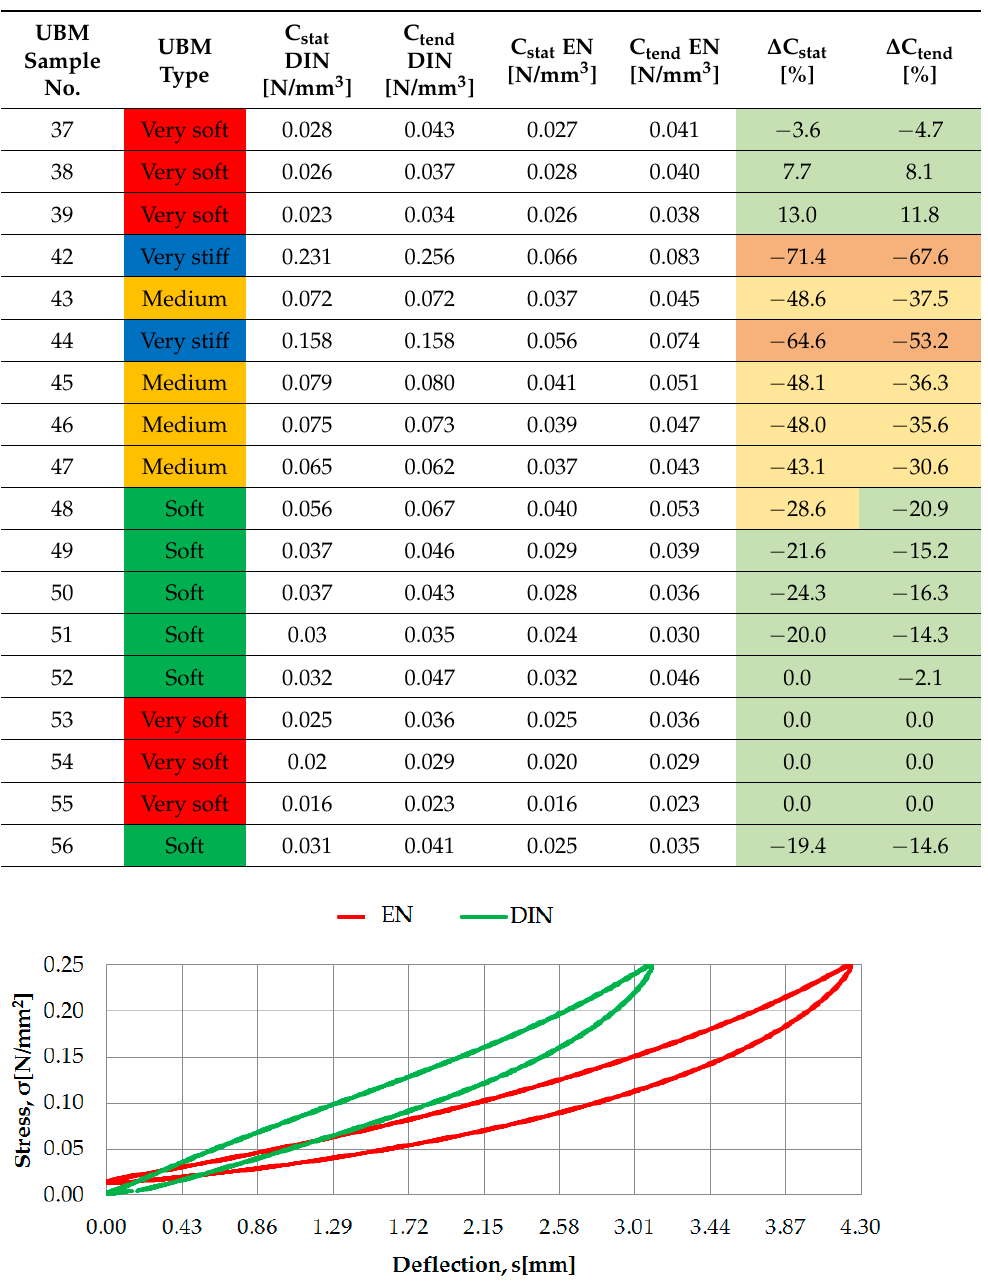
Figure 4. Static characteristics of UBM 045 determined according to DIN [23] and EN [24].